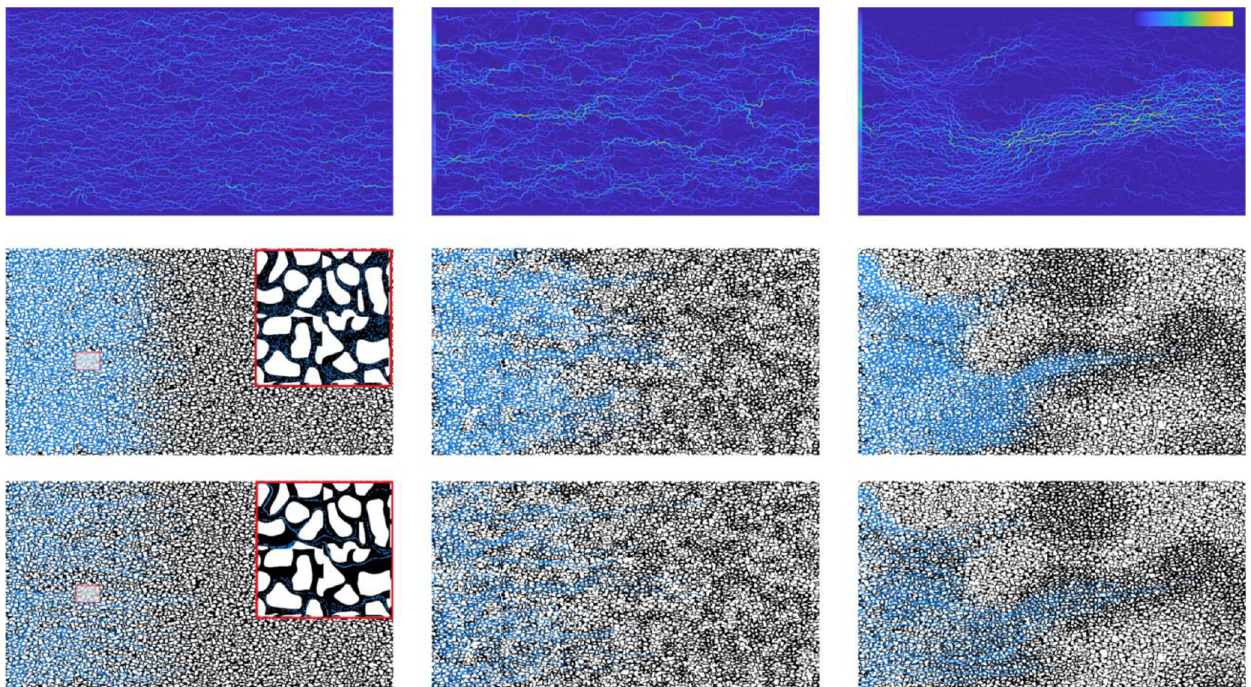
Figure 3. Fluid velocities and chemical migration in three porous media configurations (from left to right): homogeneous system, randomly heterogeneous system, and structured heterogeneous system. The upper row shows the (normalized) velocity field for the three configura- tions; the color bar represents relative velocity, with dark blue being lowest. The middle and lower rows show, respectively, numerically simulated particle tracking patterns of an inert chemical species (blue dots) at Pe = 1 (middle row) and Pe = 100 (lower row) for the three configurations (white color indicates solid phase; black color indicates liquid phase). Each system has overall dimensions of 8cm (length) × 6cm (height). Note: the particle plumes are shown at 10% of the final time of each simulation; absolute travel times differ among the plots. The insets in the left-hand-side plots of the middle and lower rows show the pore-scale chemical species distributions; note the more diffuse pattern for Pe = 1 (from Nissan and Berkowitz, 2019; © with permission from the American Physical Society